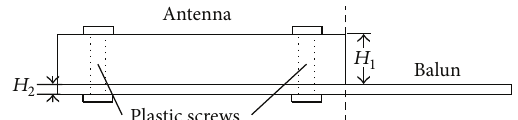
Figure 5: Side view of the F-P antenna and balun.